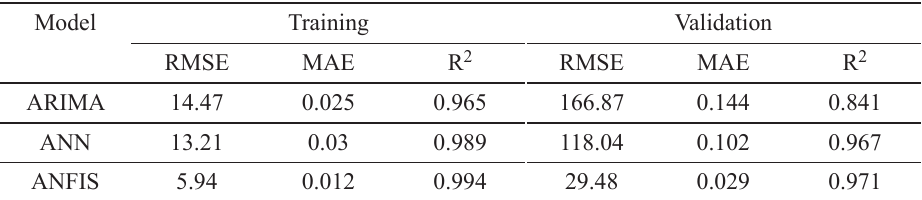
Table 2. Forecasting performance indices of models for gold price Model